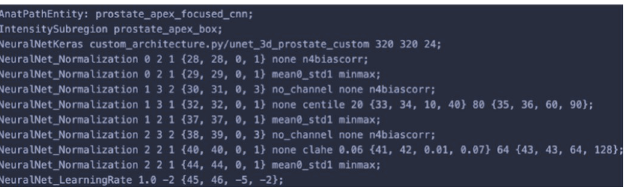
Fig 11. The SN node for prostate_apex_focused_cnn . The prostate_apex_focused_cnn semantic network node showing parameters exposed for optimization relating to DNN input normalization and learning.